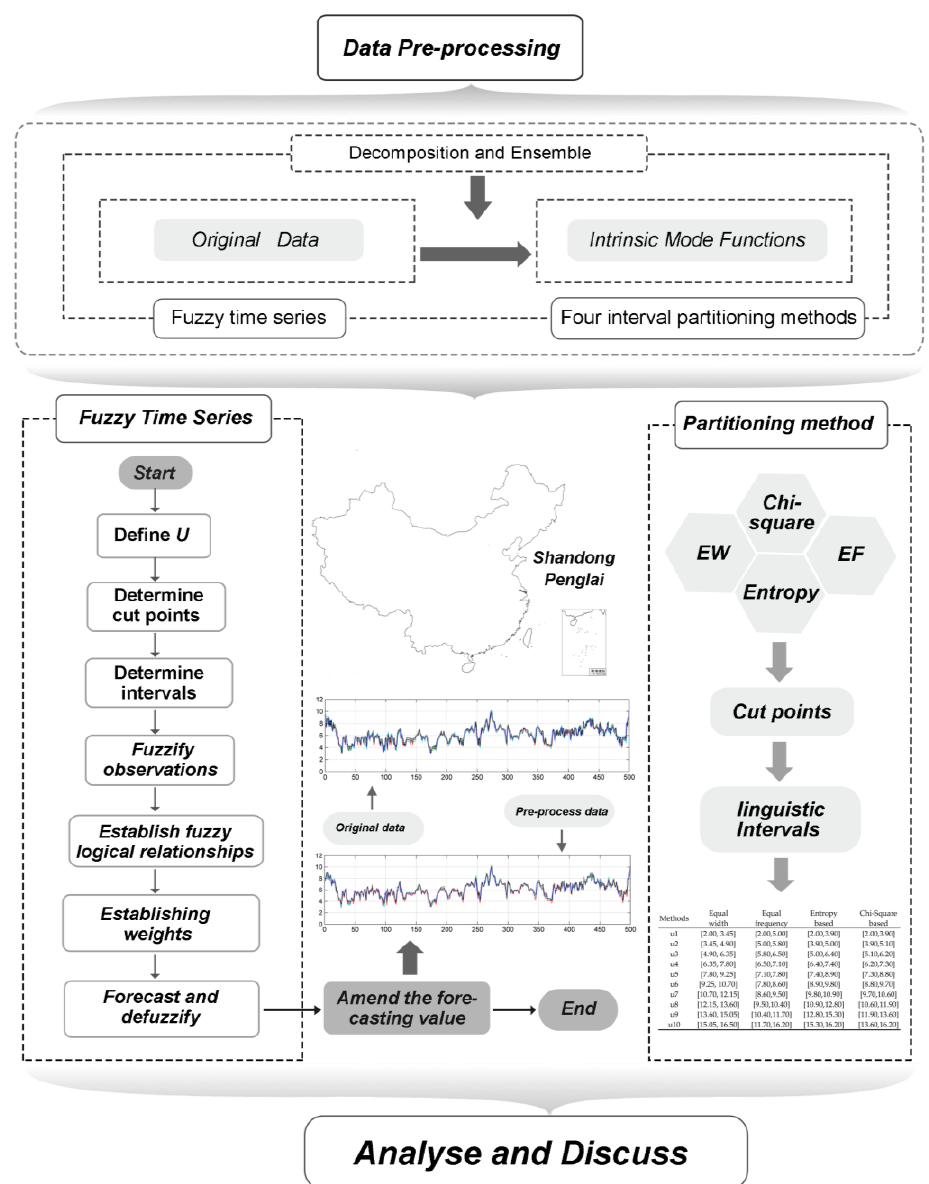
Figure 1. The flow chart of the proposed hybrid forecasting system.